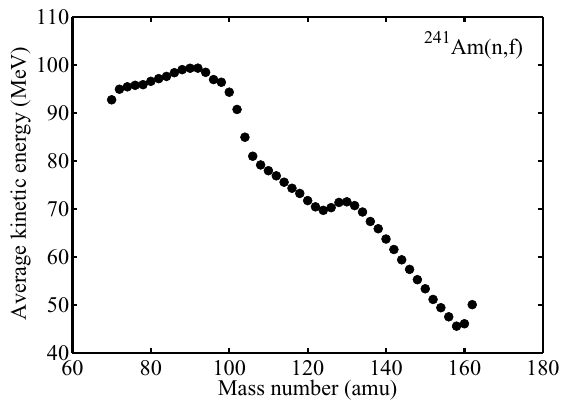
Figure 3. The relationship between the fission-fragment average kinetic energy distribution and the fission-fragment mass number of 241 Am(n,f) reaction.